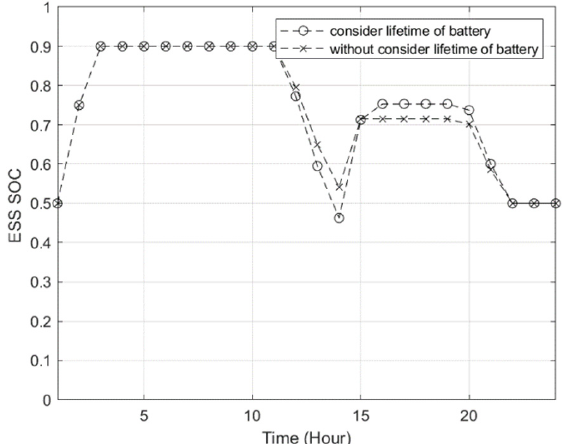
Figure 7. SOC curve of the ESS in Case 1, Case 2.